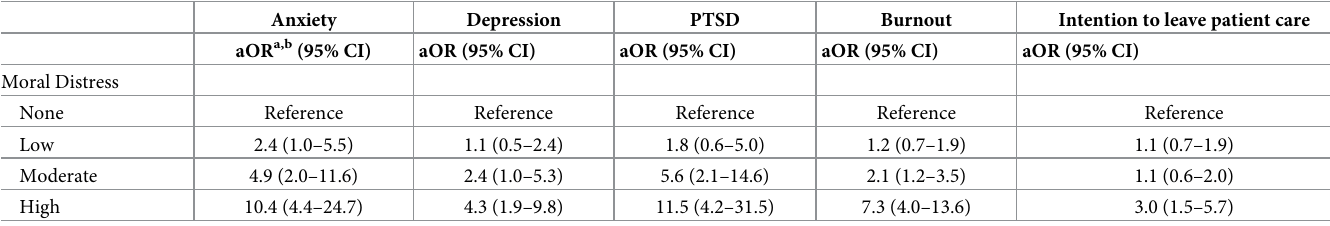
Table 2. Logistic regression associations between moral distress and mental health, burnout and intention to leave patient care.